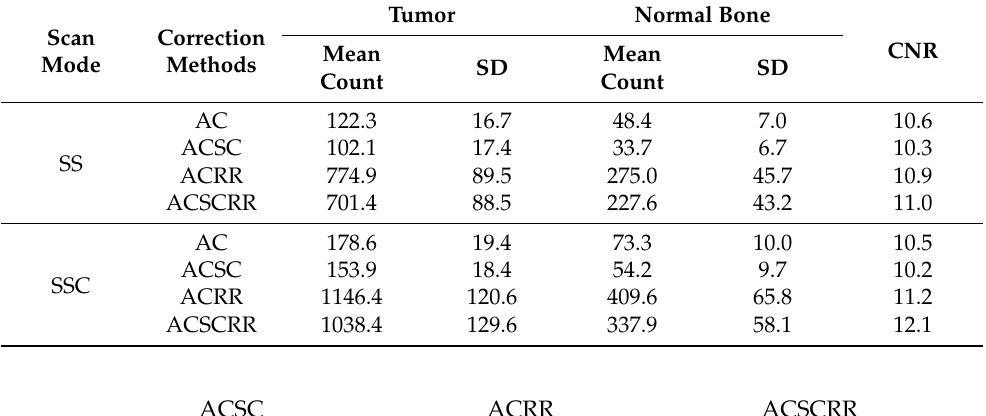
Table 4. Count, SD, and CNR results in a clinical case.